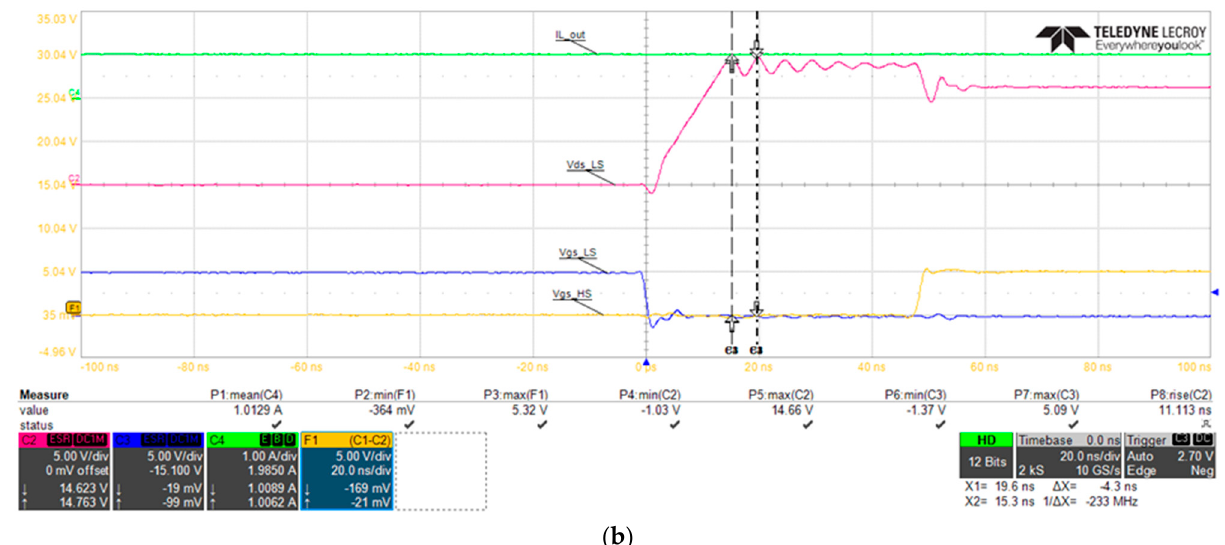
Figure 31. Switching waveforms of the converter using the monolithic device: ( a ) turn-off, ( b ) turn- on.